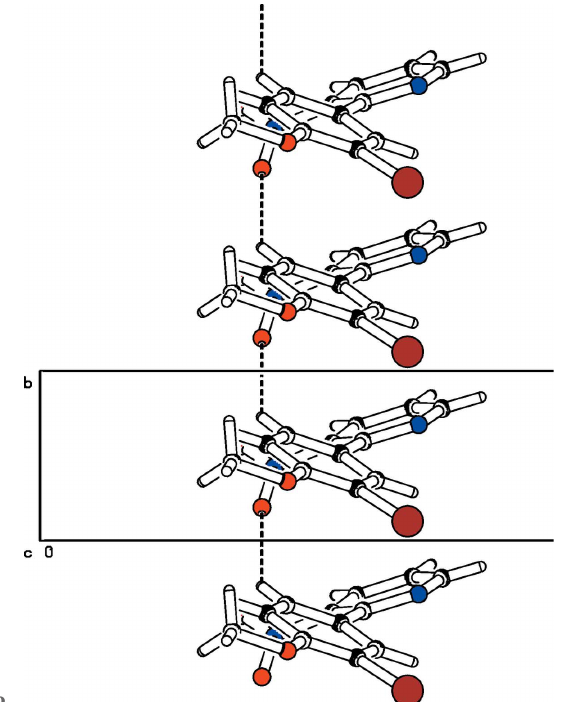
Figure 2 Partial packing diagram, viewed along the c -axis direction. Hydrogen bonds are shown as dashed lines.